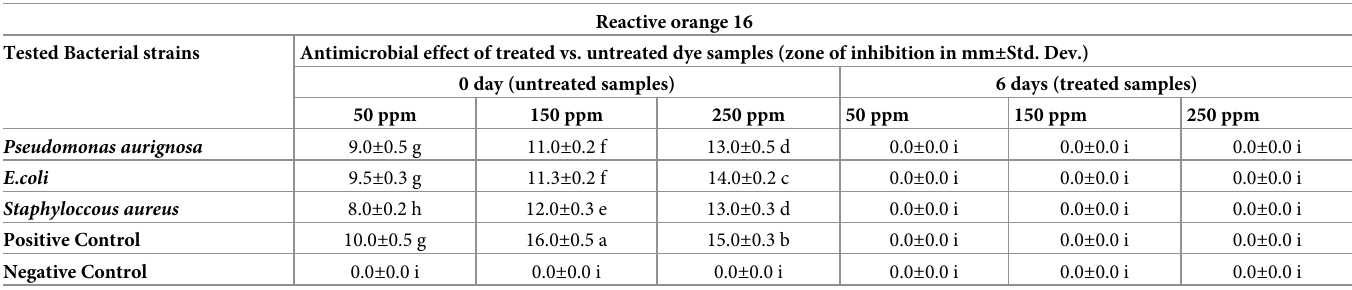
Reactive orange 16